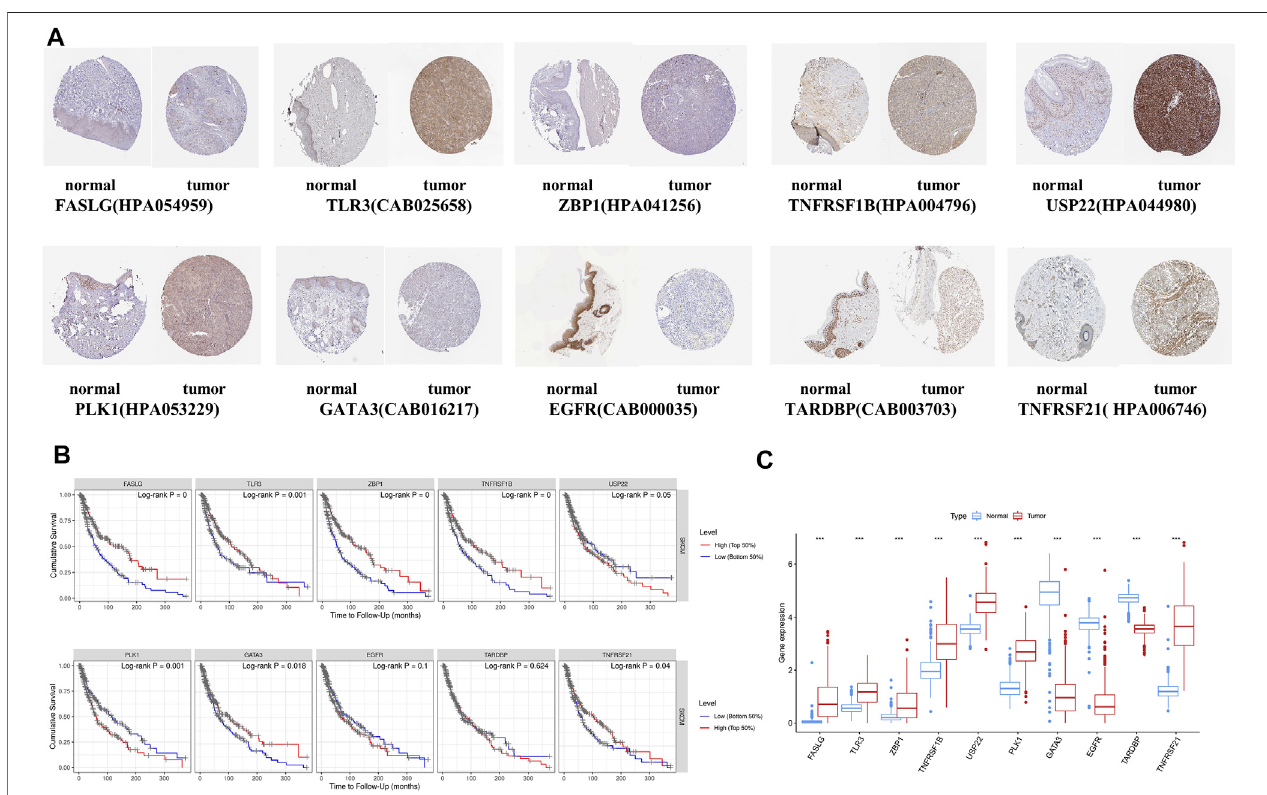
FIGURE 9 | Online database analysis. (A) Validation of the 10-gene expression in our model based on the HPA database. (B) K-M curves for high- and low- expression level subgroups based on the 10-gene signature. (C) Hub gene expression in GTEx normal, TCGA normal, and TCGA cancer tissues.